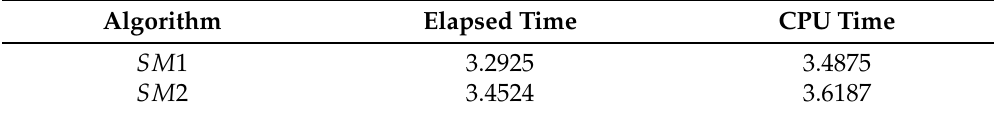
Table 6. Elapsed time and CPU time comparison between SM1 and